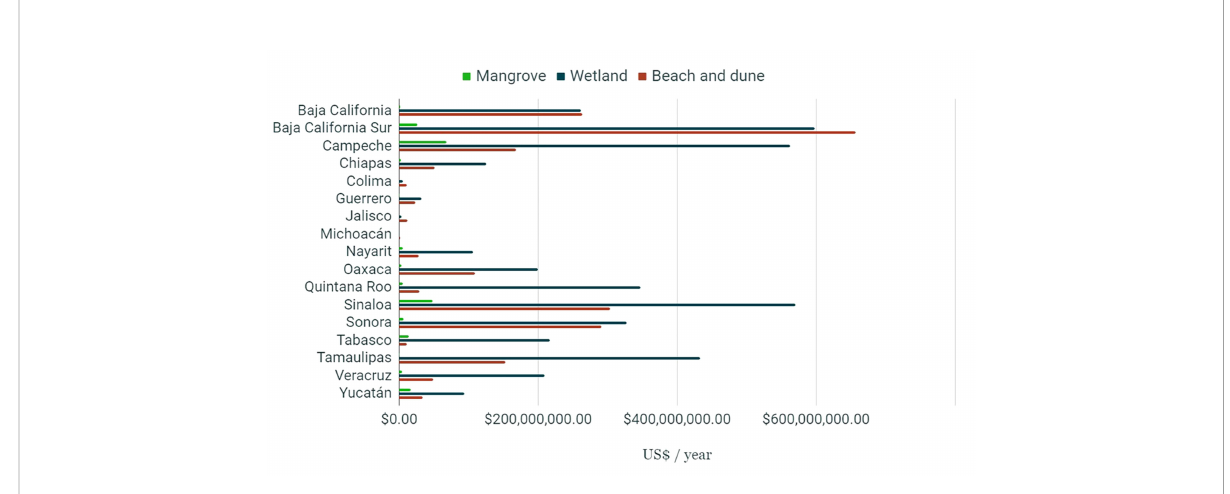
FIGURE 4 Annual economic losses by state due to the disappearance of ecosystem services in